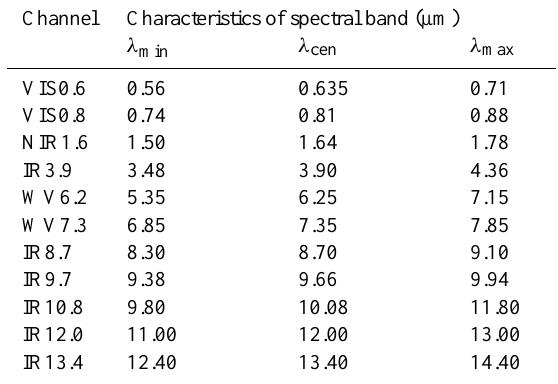
Table 1. List of channels of SEVIRI (Schmetz et al., 2002) used as explanatory variables in CM and